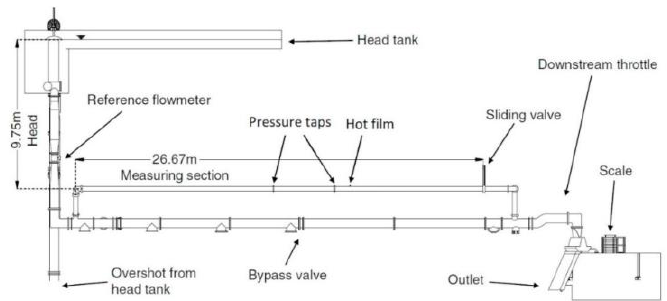
Figure 1. The water hammer test rig schematic. Figure courtesy of Sundstrom et al.